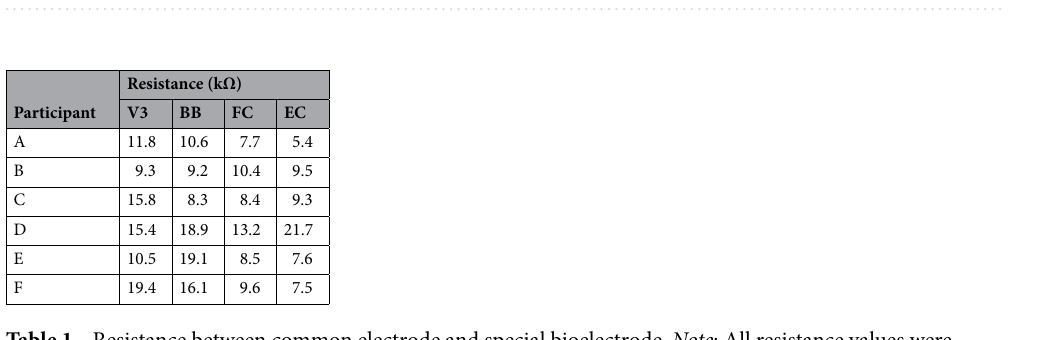
Table 1. Resistance between common electrode and special bioelectrode. Note : All resistance values were measured by a specialized resistance meter (Nihonsanteku Co., MaP811).